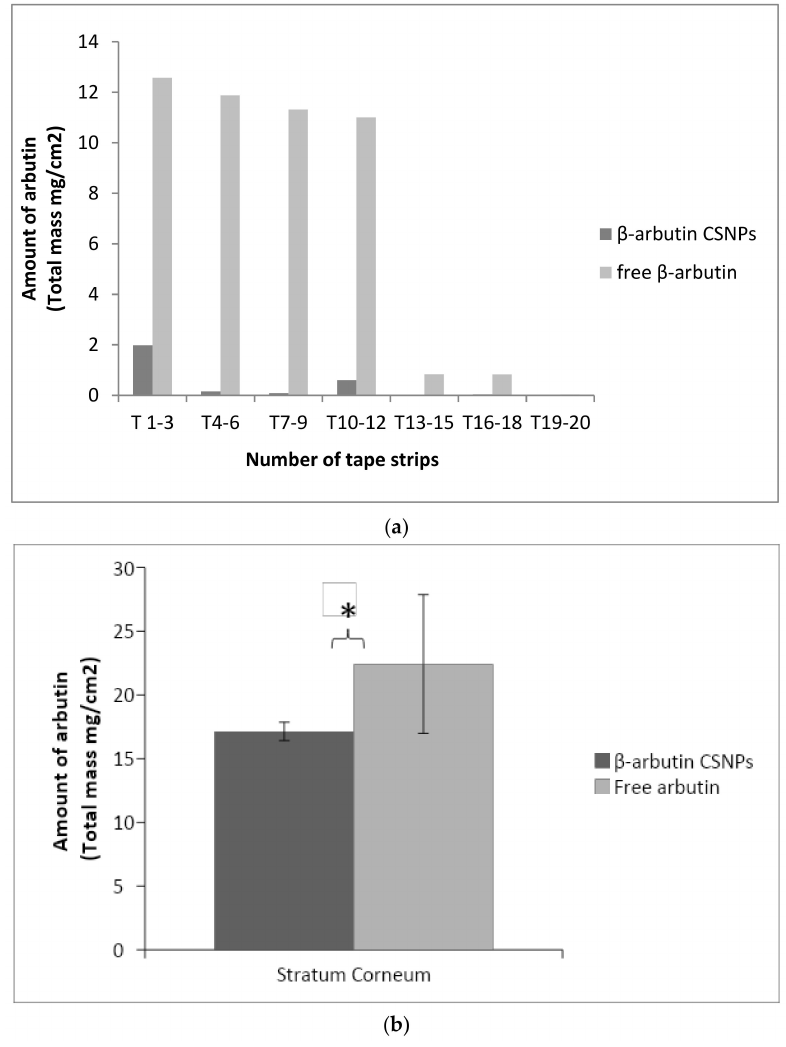
Figure 8. In vitro penetration study of 0.4% β -arbutin CSNPs and free β -arbutin. ( a ) Amount of arbutin found in the different tape strips and ( b ) Total amount of arbutin in the stratum corneum. (* indicates a significance difference, p <